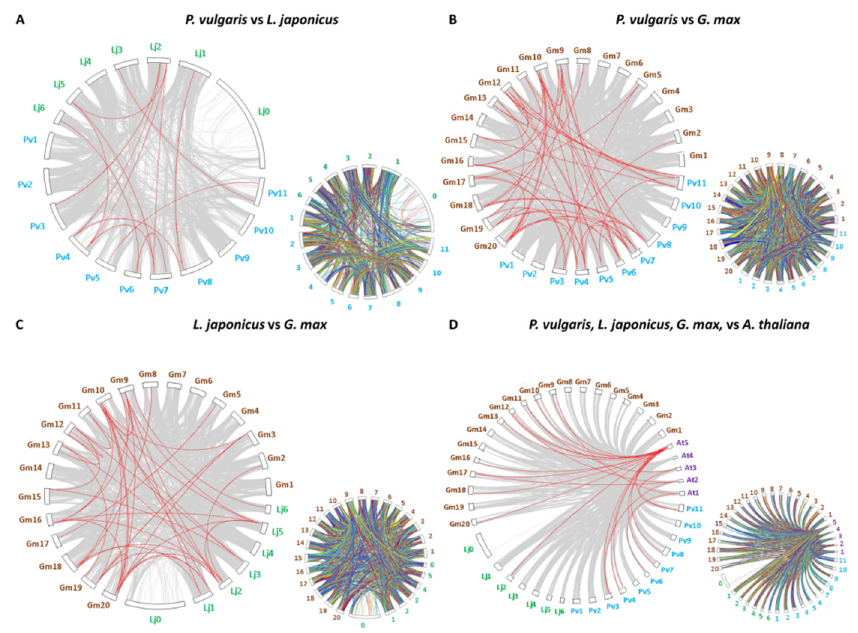
Figure 3. Synteny of the CrRLK1L genes in P. vulgaris , L. japonicus , G. max , and A. thaliana . MCScan software was used to analyze the syntenic correlation between species. ( A ) Synteny map of CrRLK1Ls between L. japonicus and P. vulgaris. ( B ) Synteny map of CrRLK1Ls between G. max and P. vulgaris. ( C ) Synteny map of CrRLK1Ls between L. japonicus and G. max. ( D ) Synteny map of CrRLK1Ls between A. thaliana and the three legumes examined. Chromosome numbers are indicated outside each figure as follows: in turquoise, P. vulgaris ; in green, L. japonicus ; in brown, G. max ; and in purple, A. thaliana . The smaller synteny maps to the right of each image represent the synteny of all the genes in the genomes compared here.